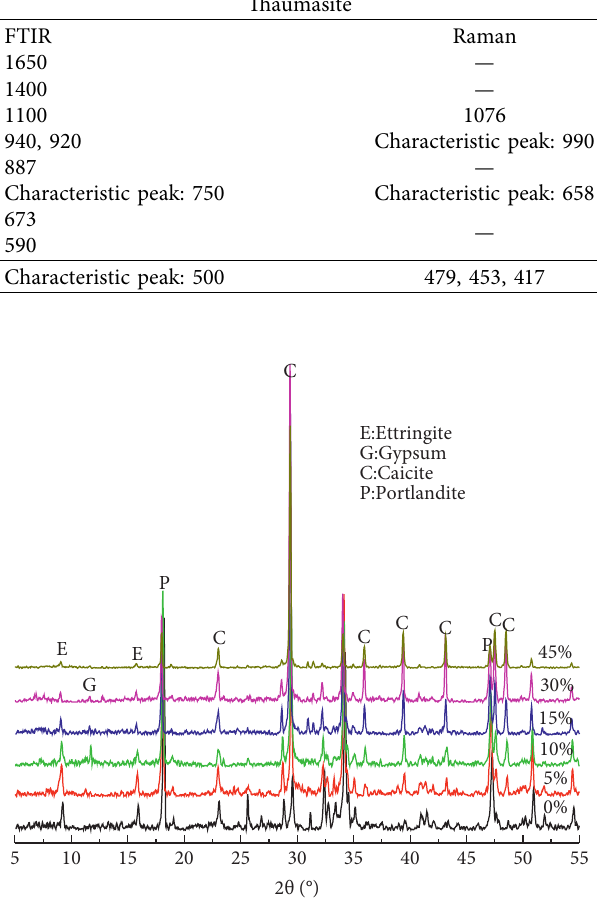
Figure 6: XRD pattern of 6 control specimens at 30